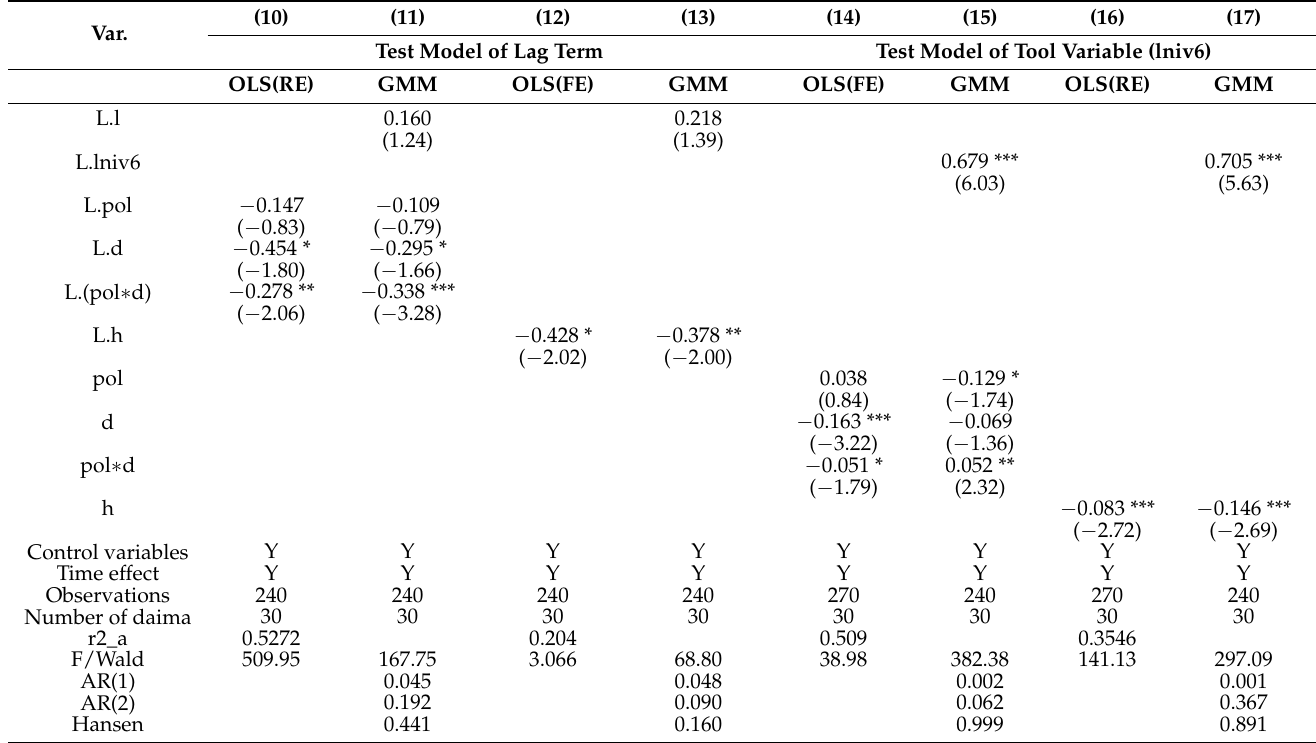
Table 4. The robustness test results of the baseline